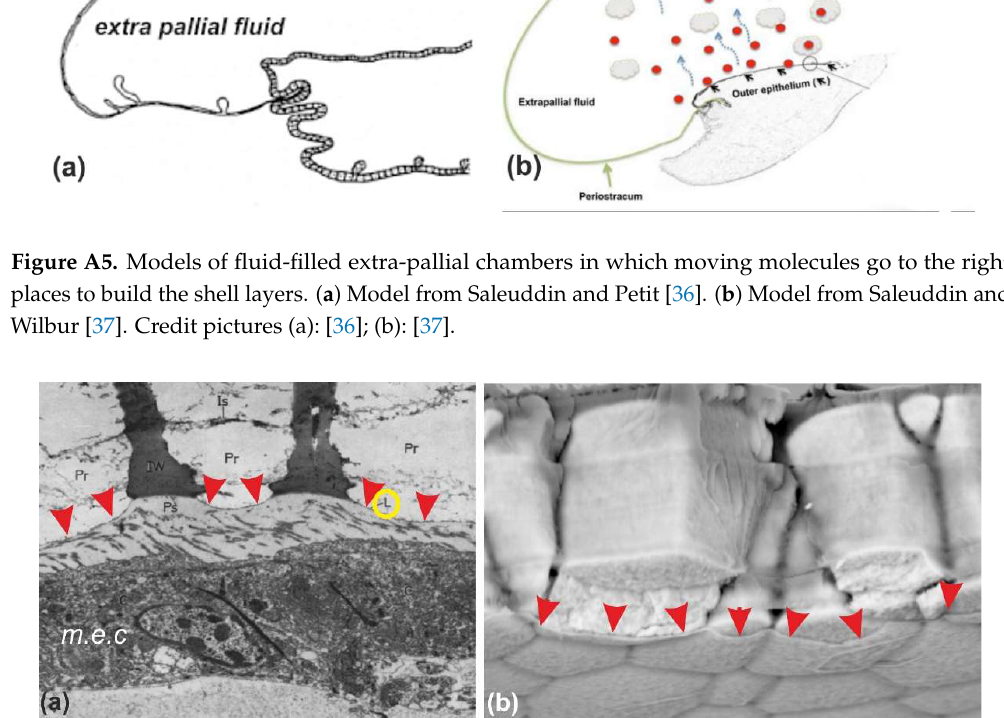
Figure A6. Comparison of the Bevelander and Nakahara figure ( a ) Transmission electron microscopy) with a SEM view of a fractured shell of Pinctada margaritifera, showing prisms and inner surface of the prismatic layer. Secretions of the mantle epithelial cell layer ( m.e.c ) are separated from the mineralized prisms by the “lamella” (L in [29]), i.e., exactly the place of the Mash and Sass membrane. ( b ) Equivalent membrane is clearly visible at the basis of the prismatic layer in P. margaritifera. Credit pictures (a): [29]; (b): Cuif and Dauphin, Proceedings of the 14th Biomineralization meeting, Tsukuba Japan, in press.